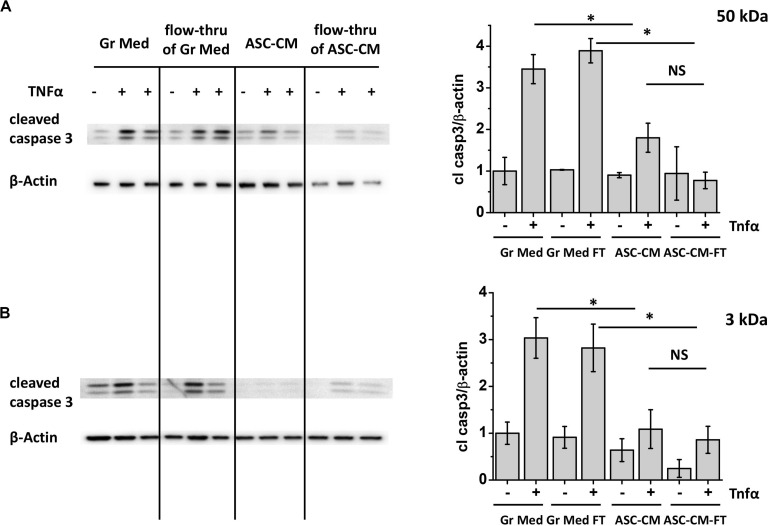
ASC-CM factors preventing endothelial apoptosis partition with MW < 3 kDa. HPAEC pretreated with the original growth media and ASC-CM, or the 50- (A) or 3-kDa (B) flow-through fractions of growth media and ASC-CM were challenged with 2 ng/ml TNFα for 4 h. Cell lysates were analyzed with antibodies to cleaved caspase 3 and β-actin (loading control). Data from three independent experiments were pooled and presented as cleaved caspase 3/β-actin ratio mean ± SEM. One-way ANOVA with Tukey post hoc was used to detect whether differences between indicated columns are significant ∗(p < 0.05) or not significant (NS).